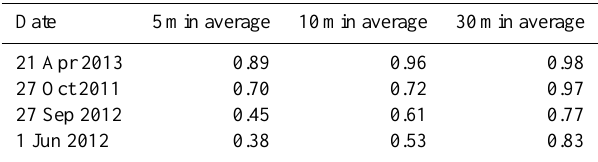
Table 5. Correlation coefficient of H from LACROS and from SE- VIRI (3x3 pixel spatial average) for different temporal averaging periods applied to both data